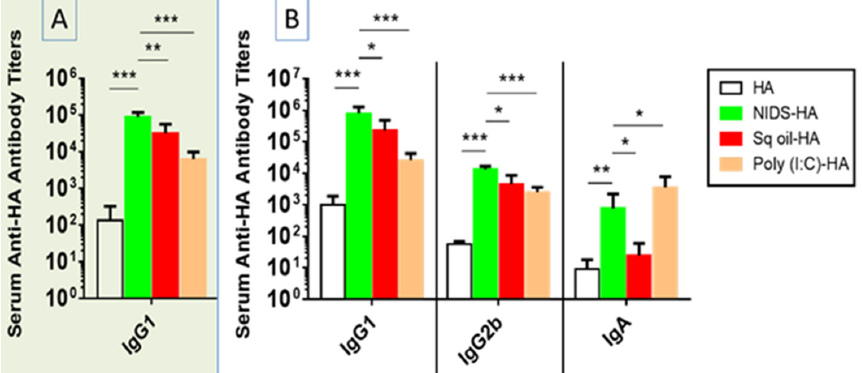
Figure 2. Effects of NIDS vs. other adjuvants on antibody responses against the Hemagglutinin HA antigen following one or two intra-muscular (IM) vaccinations in BALB/c mice. ( A ) Anti-HA IgG1 end point antibody titers measured by ELISA in sera collected at three weeks post 1st intra-muscular (IM) vaccination; ( B ) Anti-HA IgG1, IgG2b, and IgA end point antibody titers following two IM